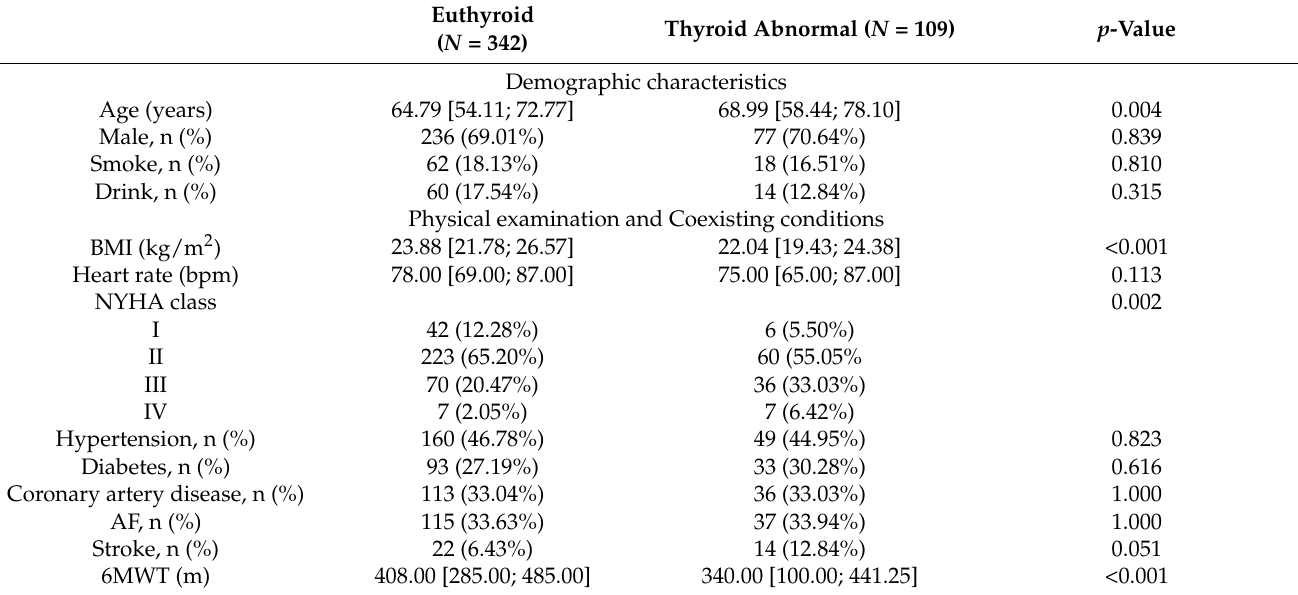
Table 1. Baseline characteristics of the included patients according to thyroid function